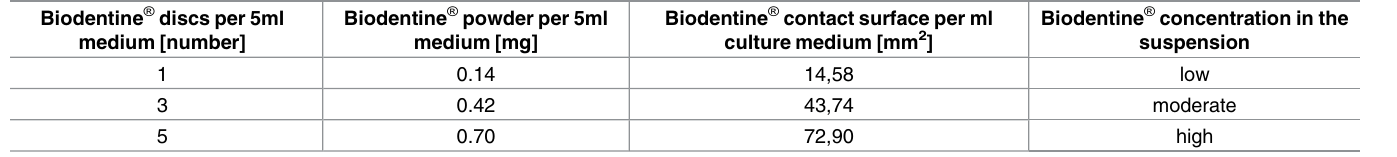
Table 1. Biodentine ® concentrations of the Biodentine ®